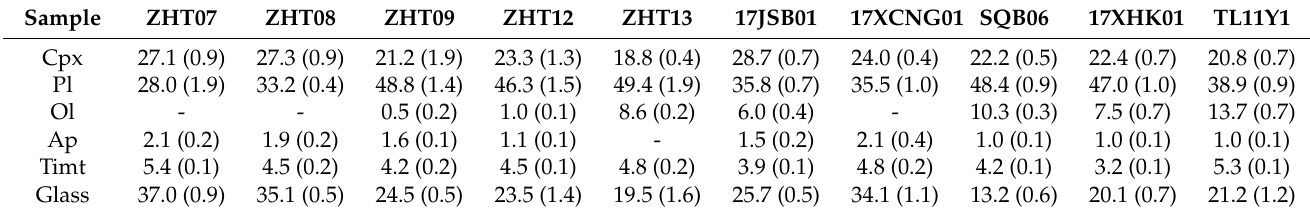
Table 1. Phase abundances of major minerals (%).